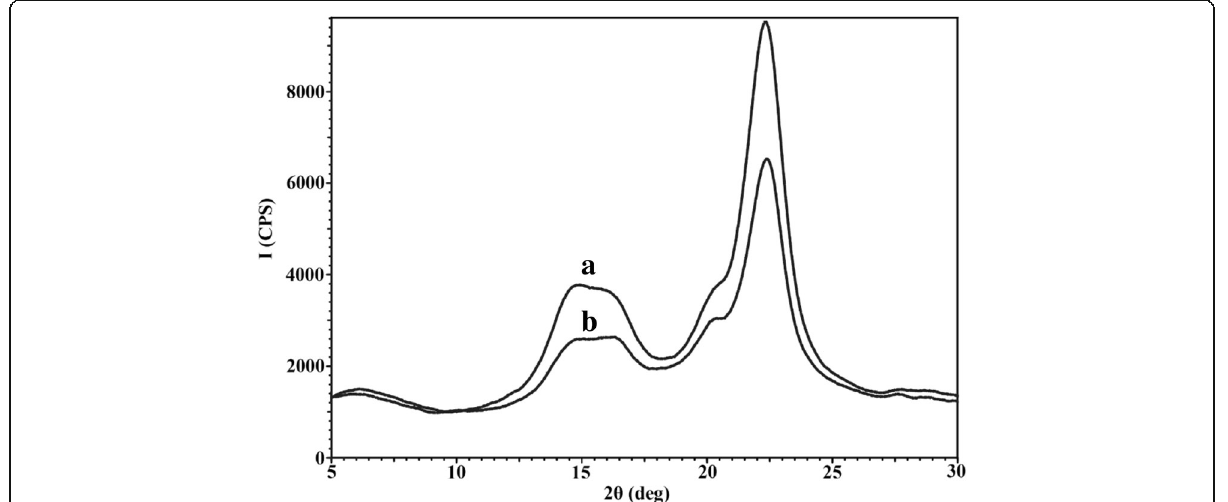
Fig. 3 XRD patterns of ( a ) MCC powder and ( b ) MMCC